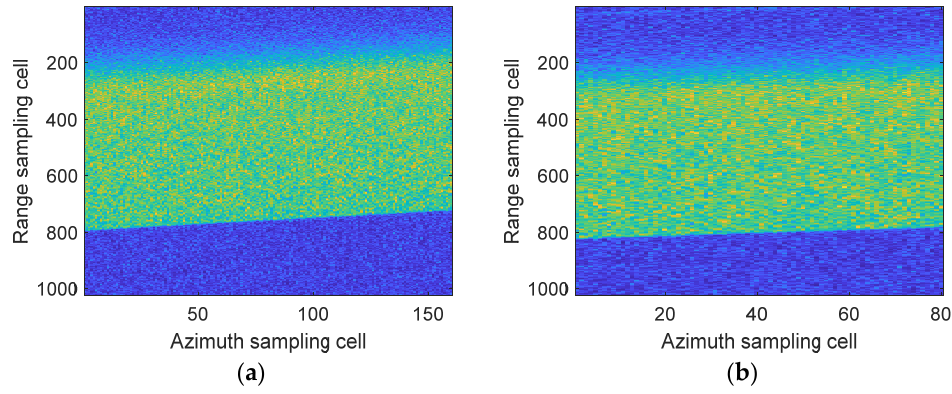
Figure 12. Raw (in complex-data type) of two receivers. ( a ) Receiver #1, ( b ) Receiver #2.